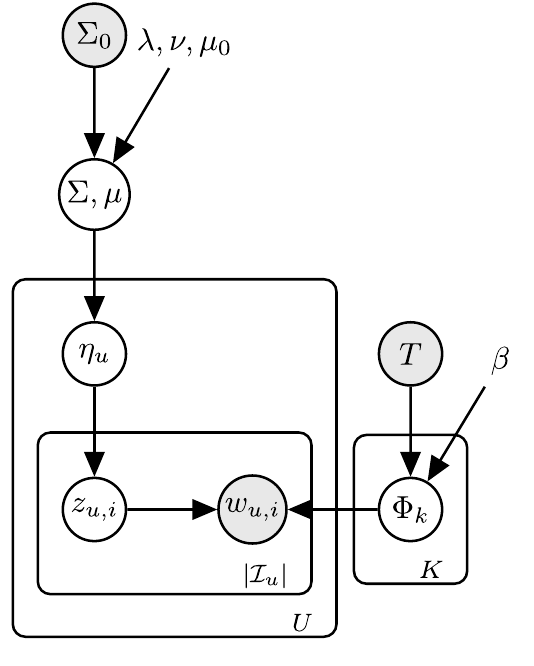
Fig. 2 Graphical model of